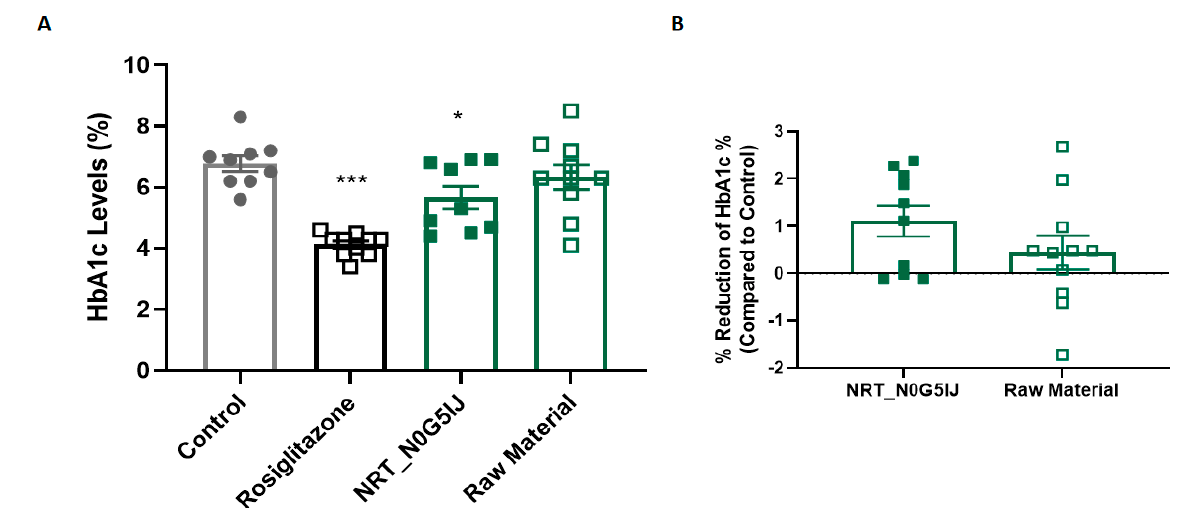
Figure 4. NRT_N0G5IJ significantly decreased HbA1c concentrations in diabetic db/db mice in a hydrolytic-specific manner. ( A ) The effect of rosiglitazone (15 mg/kg/day), NRT_N0G5IJ (400 mg/kg/day), or raw material (400 mg/kg/day) versus vehicle control on HbA1c concentrations in db/db mice was determined after 4 weeks of treatment. Mice were treated with 400 mg/kg/day of NRT_N0G5IJ, or vehicle by oral gavage. Data are the mean ± SEM ( n = 9) after 4 weeks of treatment. ( B ) The effect of NRT_N0G5IJ and associated unhydrolysed raw material on HbA1c in db/db mice relative to untreated control mice was determined. Mice were treated with 400 mg/kg/day of NRT_N0G5IJ or raw material by oral gavage, or a similar volume (5 ml/kg) of vehicle. Data are the mean ± SEM ( n = 9) after 4 weeks of treatment (* p < 0.05, *** p < 0.001). Body weights of all mice were recorded weekly. Control mice gained weight as ex-